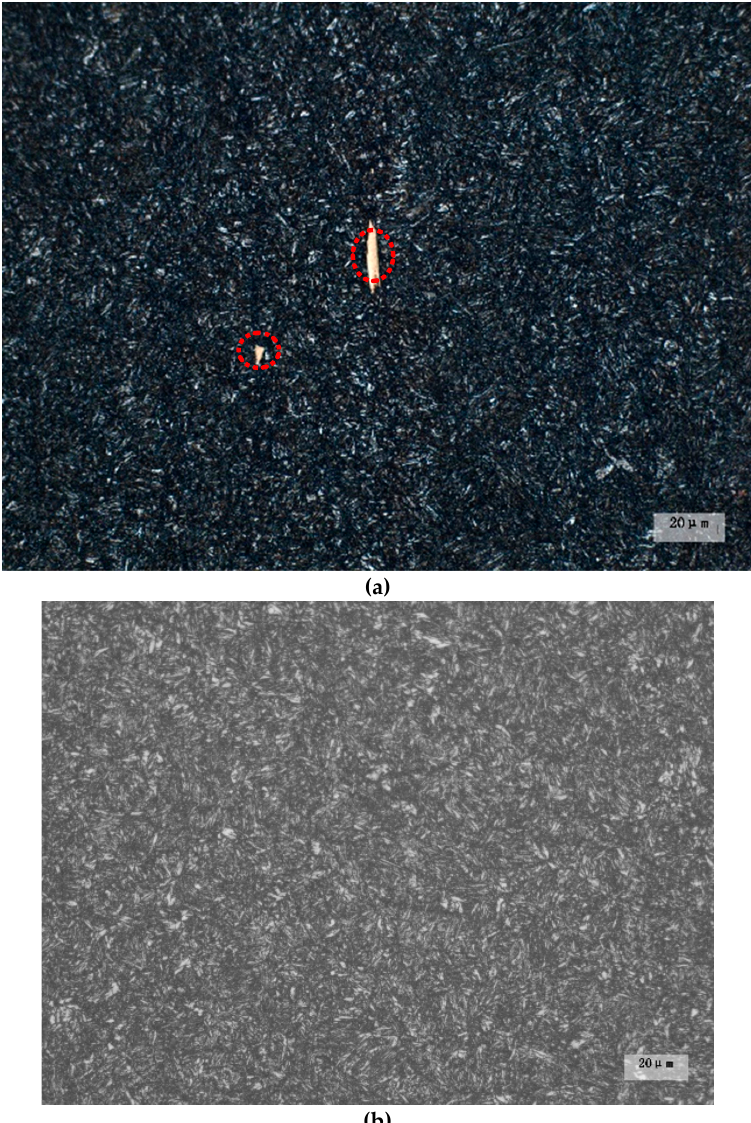
Figure 8. Microstructure morphology of the 50CrVA after fatigue testing: ( a ) S1#-1; ( b ) S2#-1.